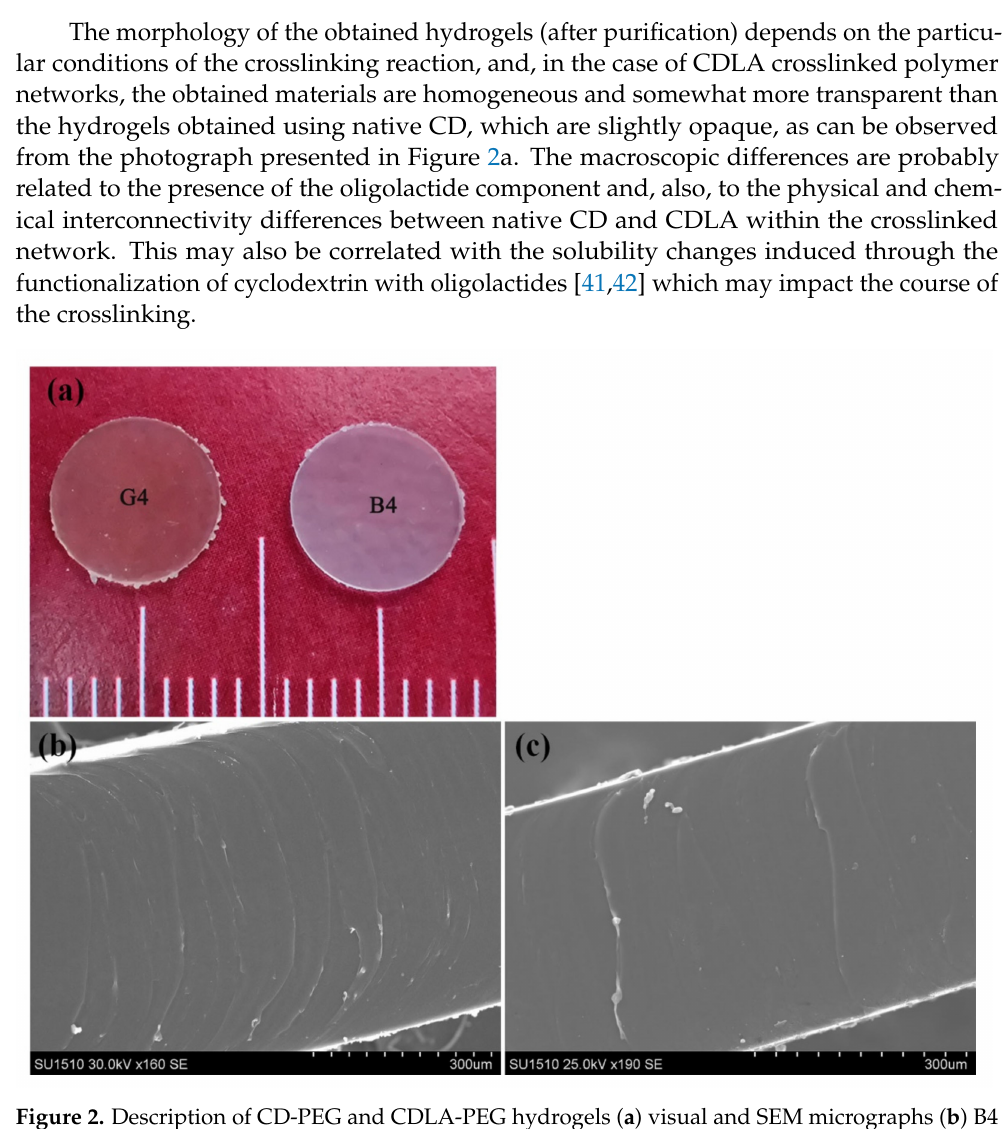
Figure 2. Description of CD-PEG and CDLA-PEG hydrogels ( a ) visual and SEM micrographs ( b ) B4 and ( c ) G4